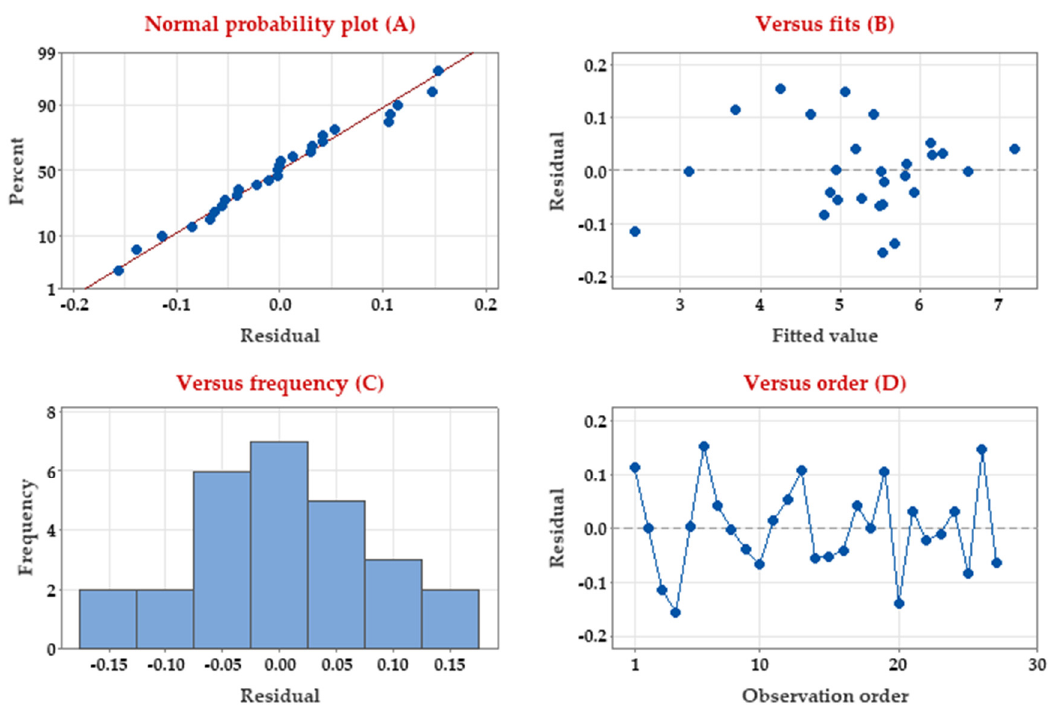
Figure 4. Residual analysis of pullulan production by A. pullulans based on the Taguchi model.